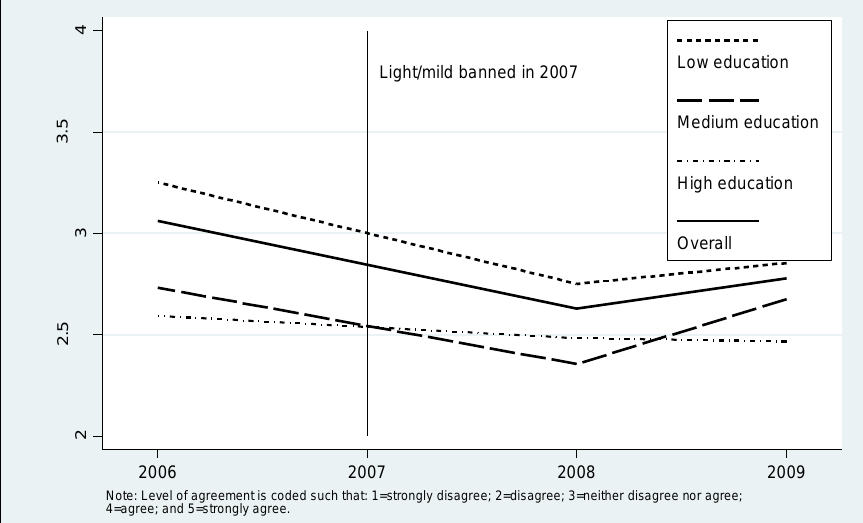
Figure 3. Mean of endorsement of ‗Light cigarettes are less harmful‘ by education.